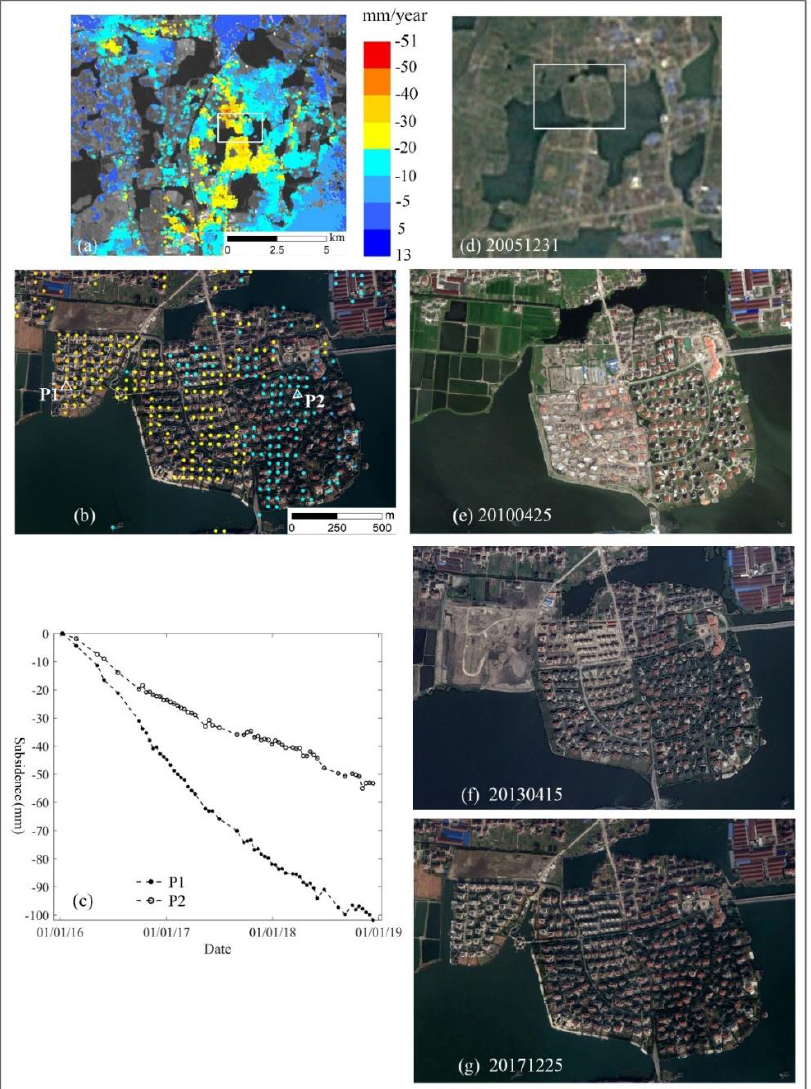
Figure 13. The enlarged view of zone E in Figure 4 is shown in ( a ). The MSV within the white-line AOI in ( a ) is shown in ( b ). ( d – g ) are 4 historic images of the AOI. The subsidence time series of two CPs marked by white-triangles in ( b ) is shown in ( c ).